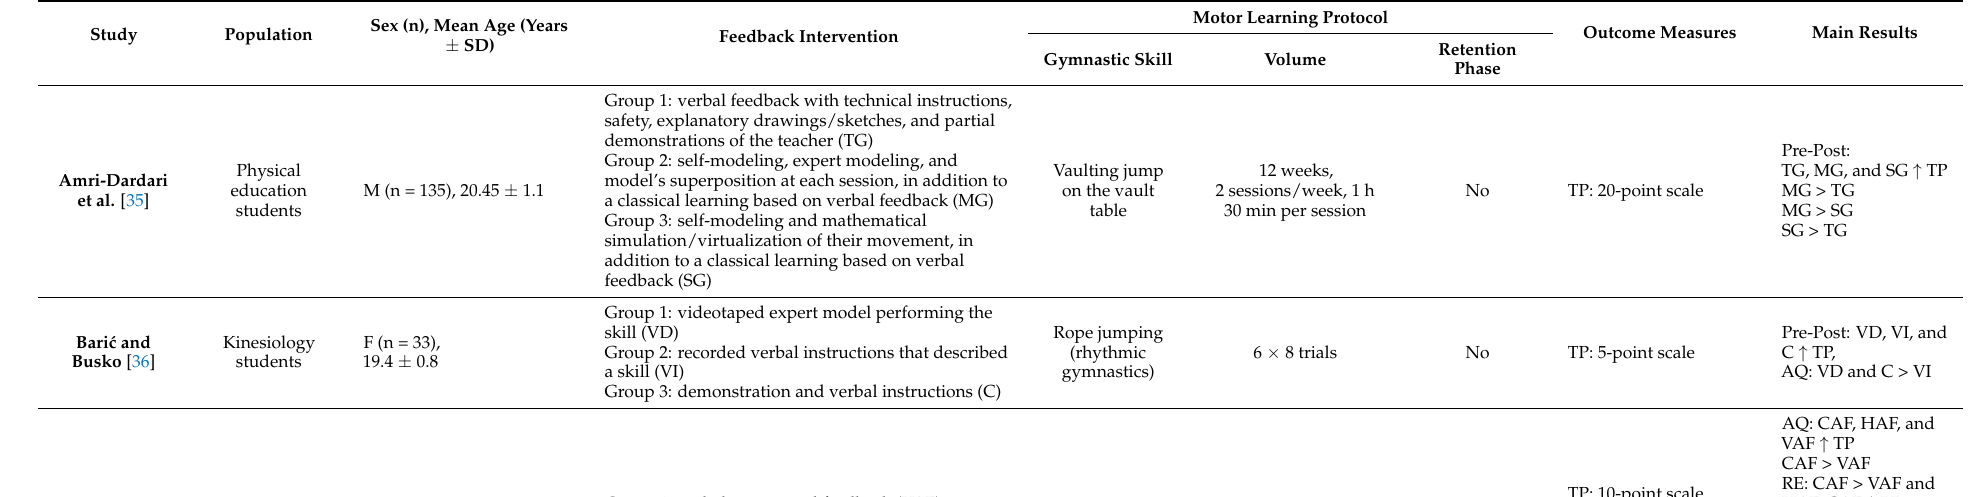
Table 2. Summary of included